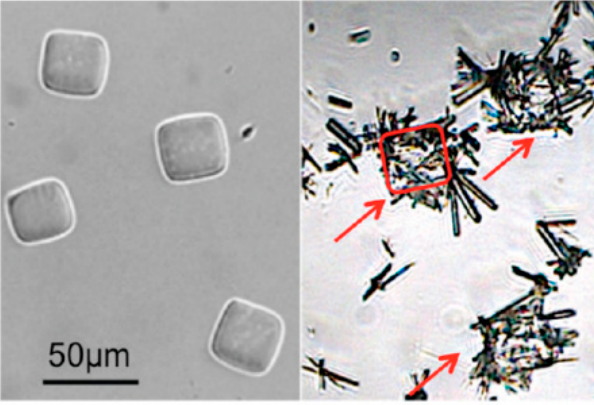
Figure 5. Optical micrographs of PEG400DA microgels as synthesized ( left ) and CBZ metastable form II needles grown on microgels ( right ). 3 microgels covered with CBZ needles are indicated with red arrows and the contour of the middle one is traced with a red line to delineate the cubic gel. Reprinted with permission from [107], the American Chemical Society,